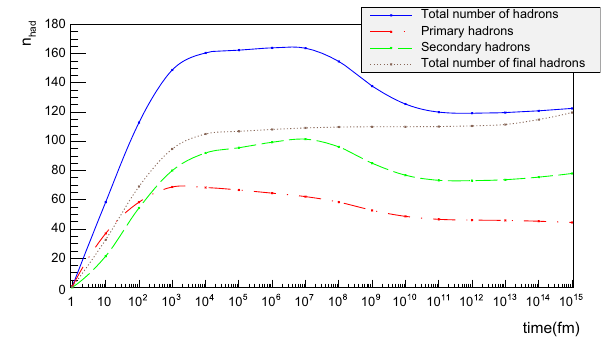
Fig. 18 Invariant time τ distribution of primary hadrons in q ¯ q systems